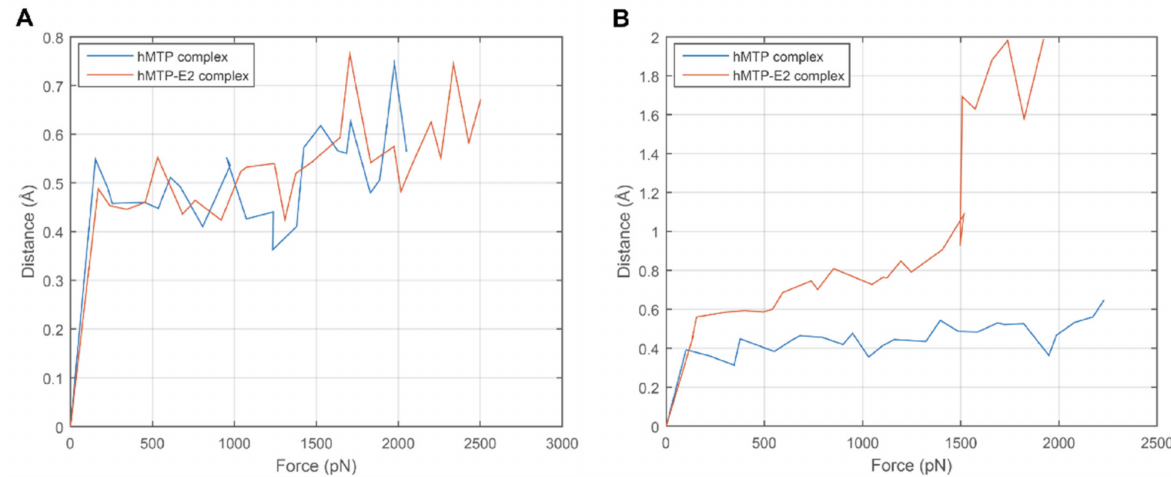
Figure 6. Changes of distances between hMTP α subunit and hPDI with the SMD forces during the SMD simulation process at the initial stage (the first 0.5 ns). For convenience of description, SMD simulations using the conformations after MDs with and without a hydrogen bond constraint are called the first and second SMDs, respectively. ( A ) Changes of distances between hMTP α subunit and hPDI with the SMD forces during the first SMDs. ( B ) Changes of distances between hMTP α subunit and hPDI with the SMD forces during the second SMDs. The SMD forces and distances shown here are the averages of the SMD forces and distances between hMTP α subunit and hPDI in the ten SMD trajectories for each complex,